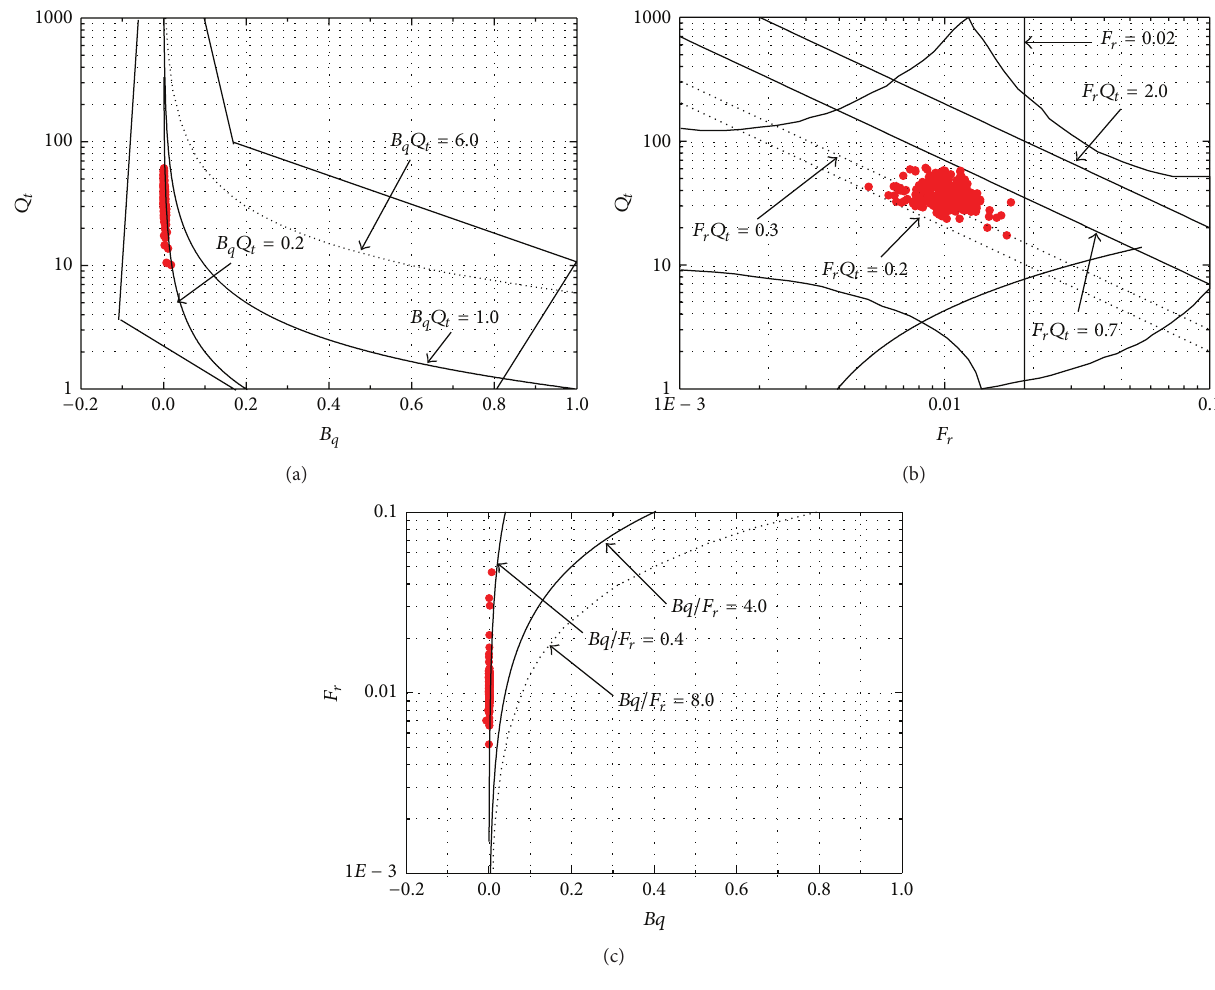
Figure 6: Contoured plots of 𝐵 𝑞 - 𝑄 𝑡 , 𝐹 𝑟 - 𝑄 𝑡 , and 𝐵 𝑞 - 𝐹 𝑟